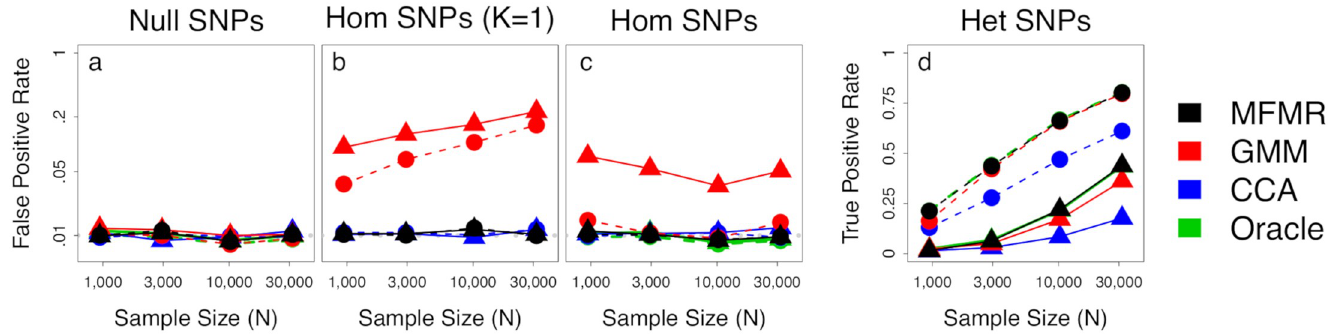
Fig 1. SNP heterogeneity tests at nominal p = .01. SNPs are either null (a); homogeneous (Hom, c); or truly heterogeneous (Het, d); we also test Hom SNPs in simulations with no subtypes (b). FPR is shown on the log scale. Hom SNPs explain 4% of variance and Het SNPs explain .4% (triangles) or vice versa (circles).